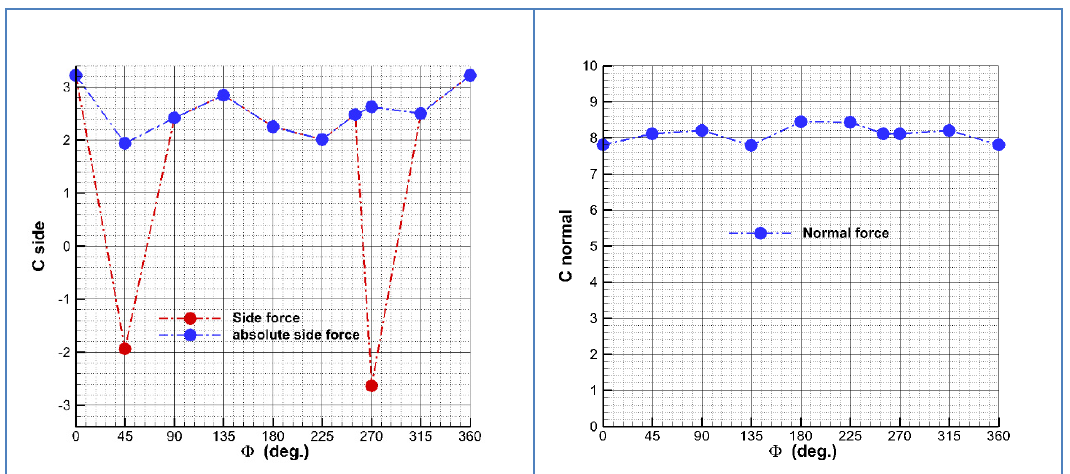
Figure 7. Global force coefficients versus orientation angle at Ma = 0.2, Re = 2 × 10 6 and α = 45 degrees. Reference unstructured grid.